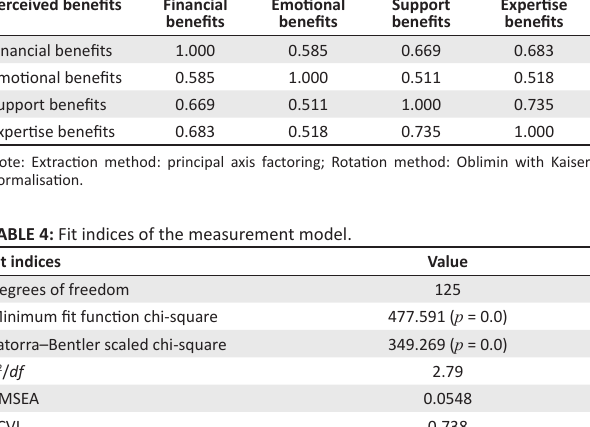
TABLE 3: Results of the exploratory factor analysis: Factor correlation matrix perceived benefits Perceived benefits